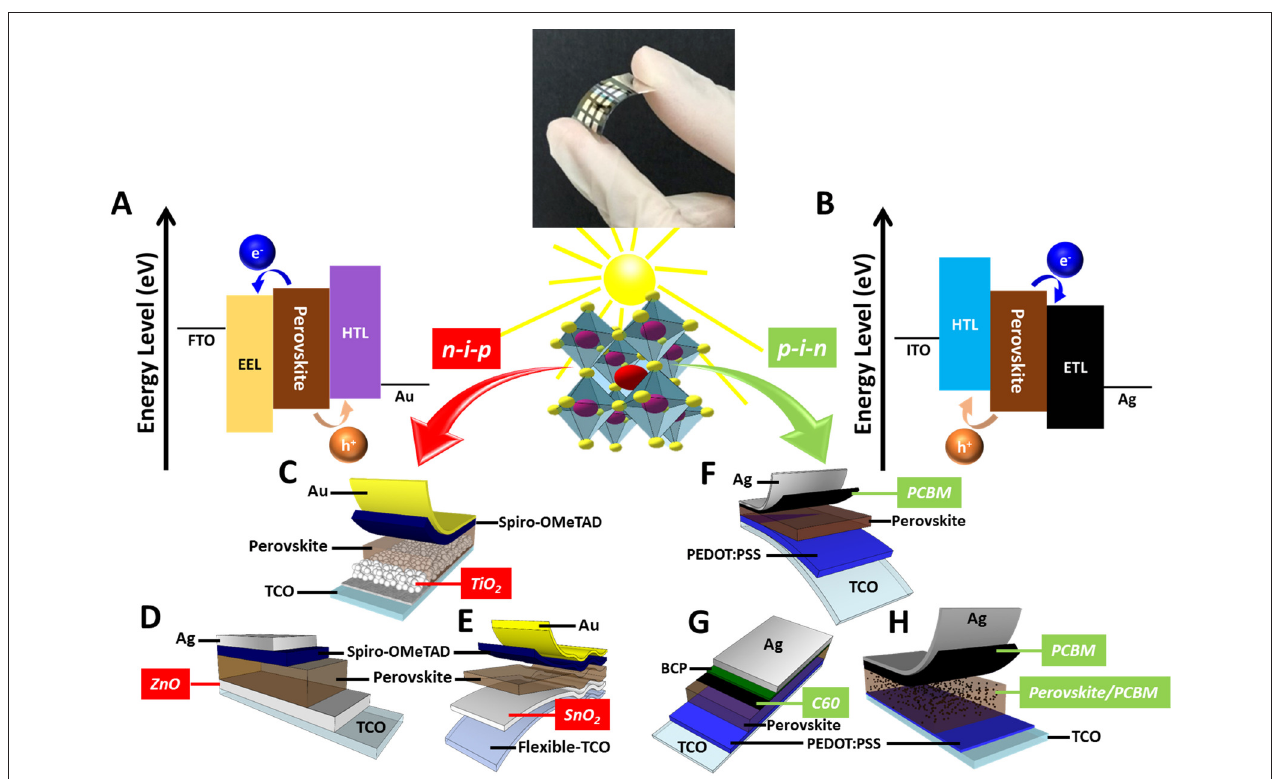
FIGURE 1 | Schematic diagram of (A,B) energy level, (C–H) device structure of PSC prepared by low-temperature